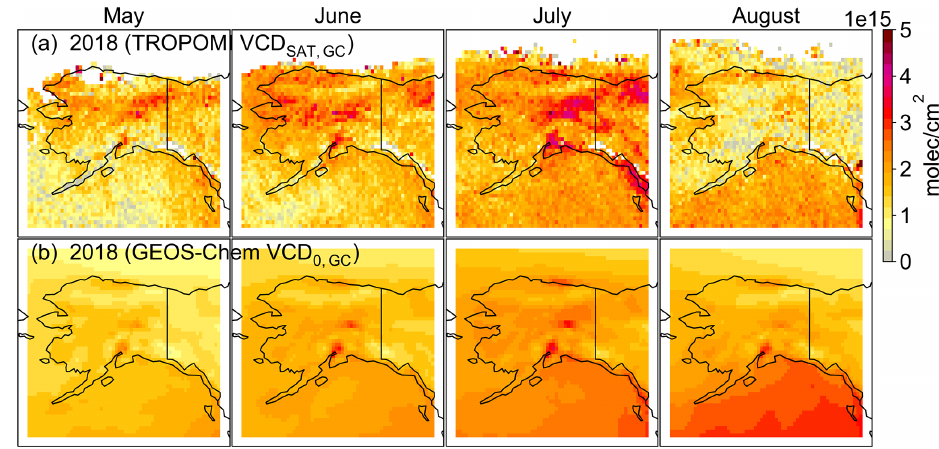
Figure 2. Reprocessed TROPOMI HCHO VCD SAT , GC and background in the summer of 2018. (a) reprocessed TROPOMI HCHO VCD SAT , GC , (b) HCHO background VCD 0 , GC used in the reprocessed TROPOMI product, provided by GEOS-Chem. GEOS-Chem re- sults are applied the same local noon time window (12:00–15:00) AKDT. TROPOMI data have been regridded to GEOS-Chem output spatial resolution (0 . 5 × 0 . 625 ◦ ).